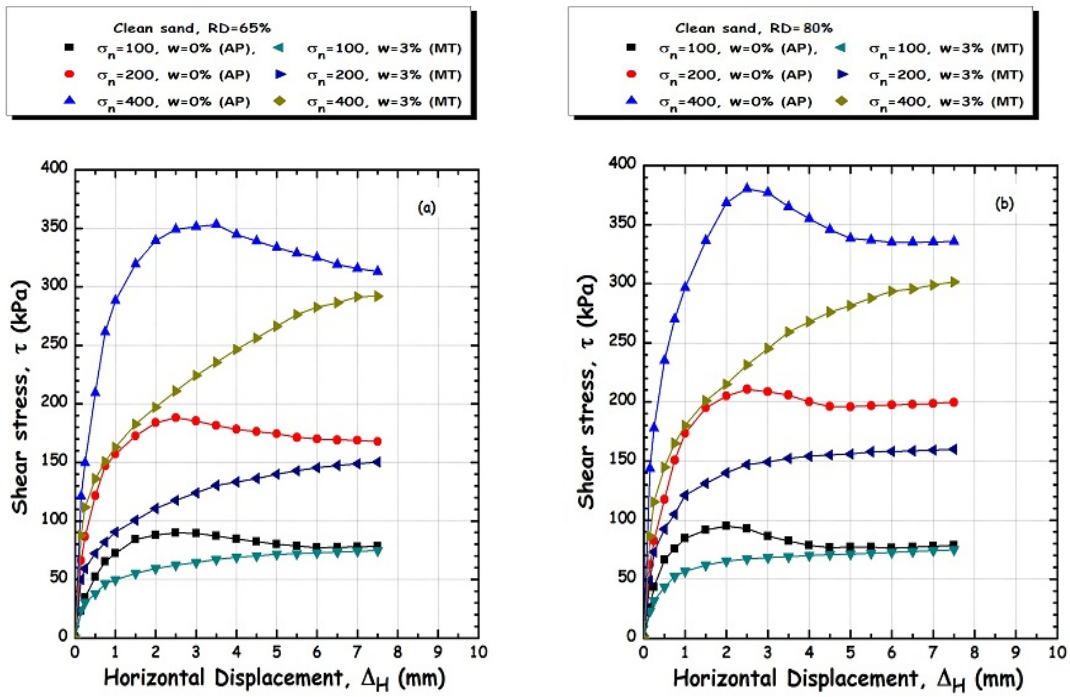
Figure 23: Effect of the depositional method on the mechanical behaviour of clean sand: (a) variation of the shear strength versus horizontal displacement (RD = 65%), (b) variation of the shear strength versus horizontal displacement (RD =